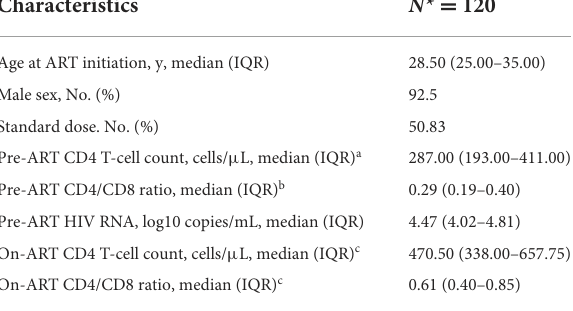
TABLE 1 Clinical characteristics of study population.